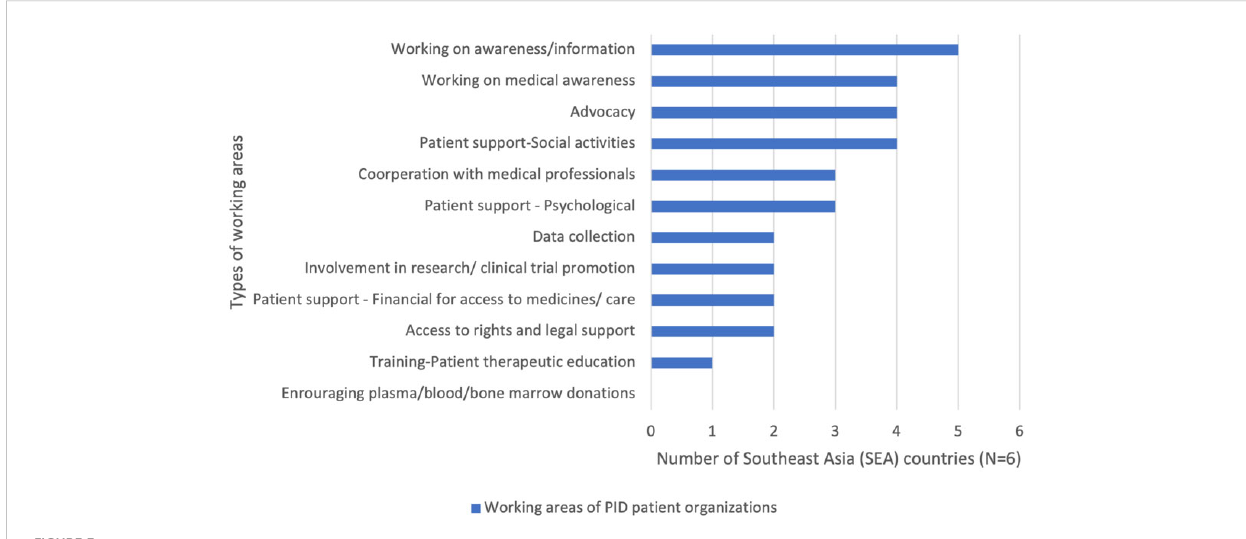
FIGURE 3 Main working areas for Primary Immunode fi ciencies (PID) patient organization in Southeast Asia (SEA). Notes: The PID Life Index identi fi ed 12 working areas by patient organizations. We used descriptive analysis to compare the frequency of types of working areas in SEA. The results were expressed in n (%), where n represented the number of